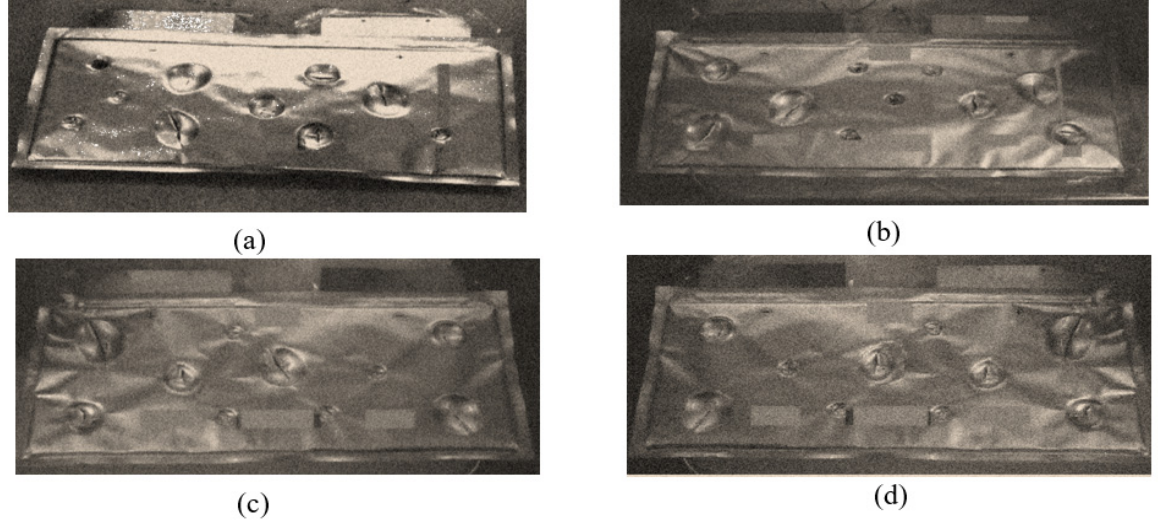
Figure 5. Cell-1 post test ( a ), cell-2 post test ( b ), cell-3 post test ( c ), and cell-4 post test ( d ).